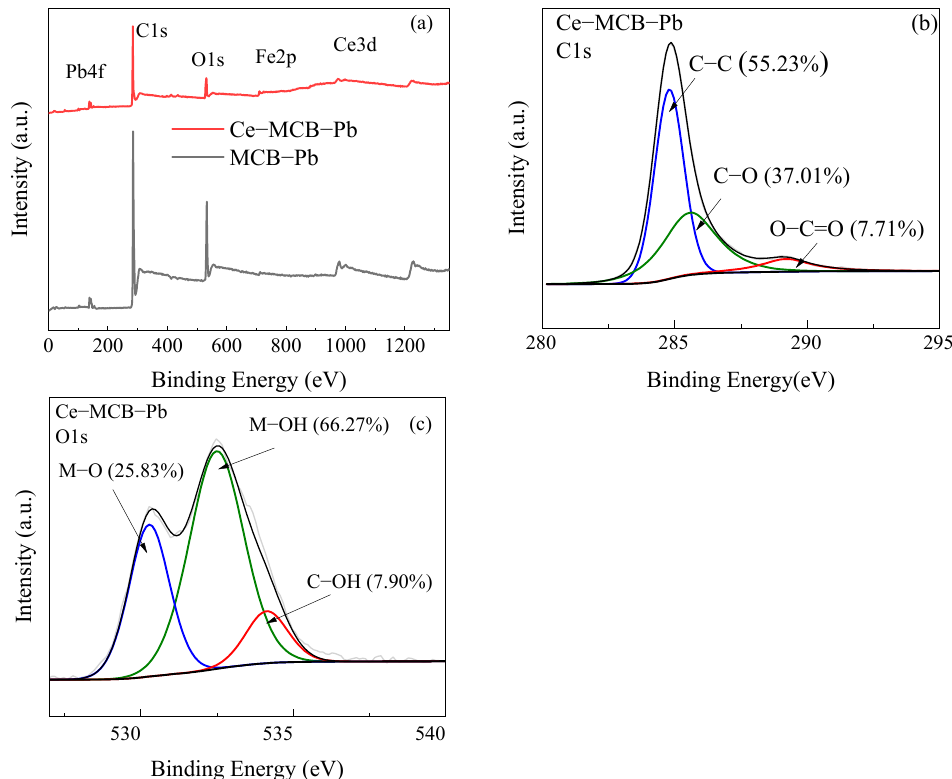
Figure 19. The XPS surveys of MCB-Pb and Ce-MCB-Pb ( a ) C 1 s ( b ) and O1s ( c ) spectra for the Ce-MCB-Pb.